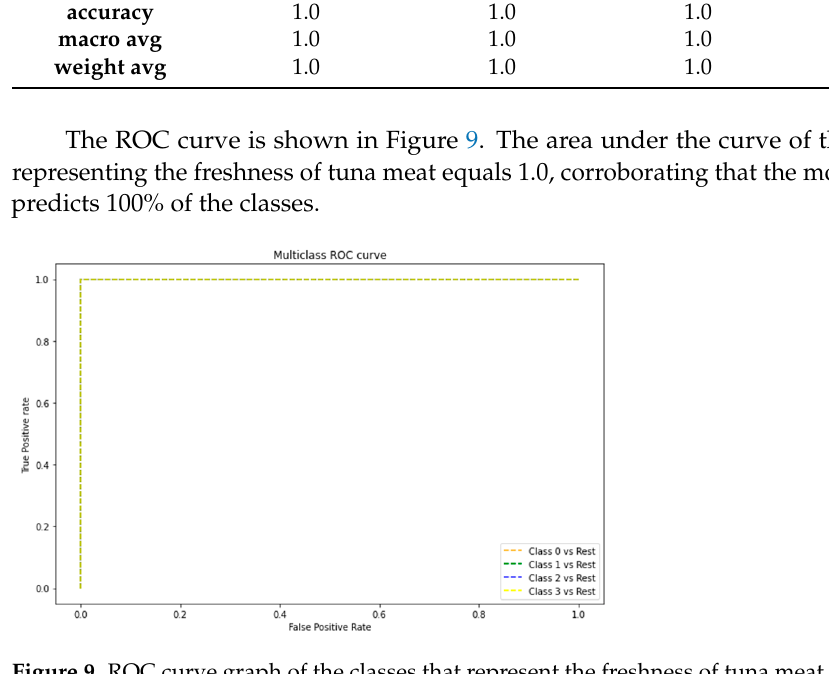
Figure 10. Feature importance graph for the Ensemble model generated by AutoML for tuna meat freshness classification. To illustrate how well-used the class balancing techniques were, we generated the CM from a prediction made by the Ensemble for freshness tuna classification, Figure 11. We realized that 100% of the samples were classified assertively.